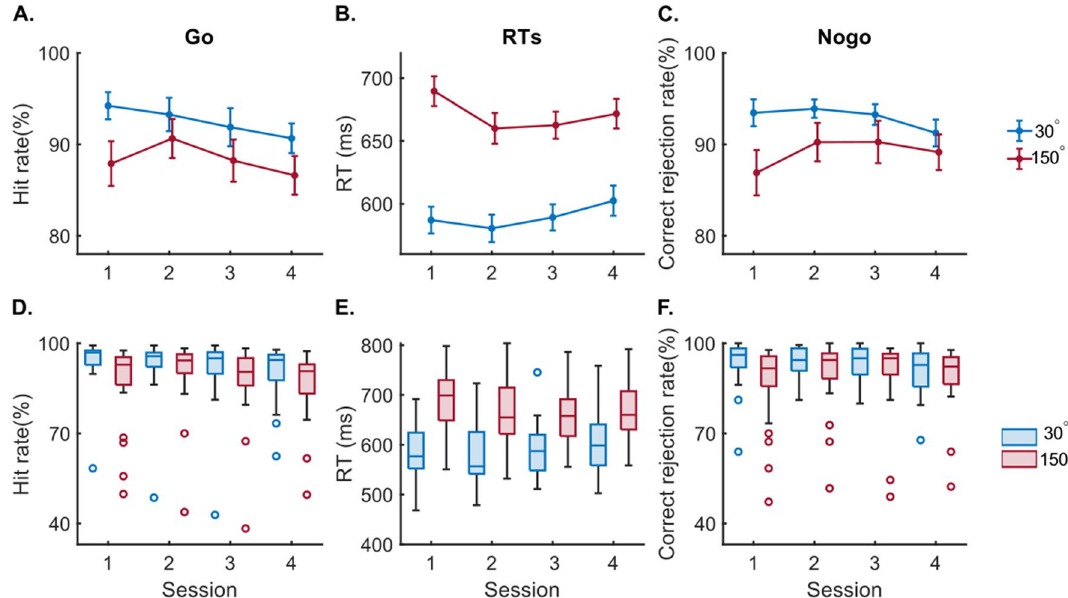
Figure 1. Results of behavioral data. ( A ) shows the rate of correct responses (hit rate) (mean and SEM), ( B ) reaction times (RTs in ms) for each session in Go trials (mean and SEM), ( C ) shows the correct rejection rate (mean and SEM) in Nogo trials for each session. Figure parts ( D – F ) show boxplots of the data corresponding to figure parts ( A – C ). Each dot represents an outlier. Outliers are defined by default using Matlab ‘boxchart’